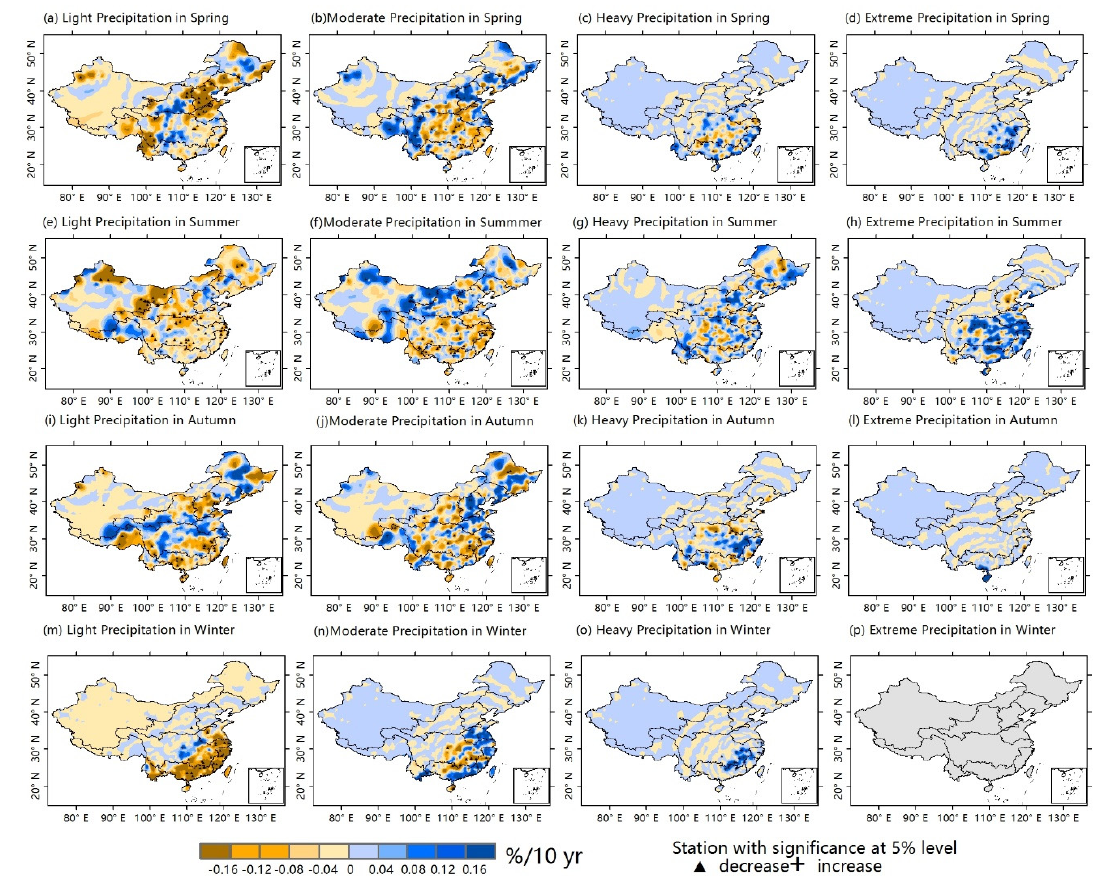
Figure 7. Seasonal trends in precipitation intensity proportions during 1960–2013. ( a – d ) Spring; ( e – h ) summer; ( i – l ) autumn; and ( m – p ) winter. For each season, the maps show light, moderate, heavy, and extreme precipitation from left to right.